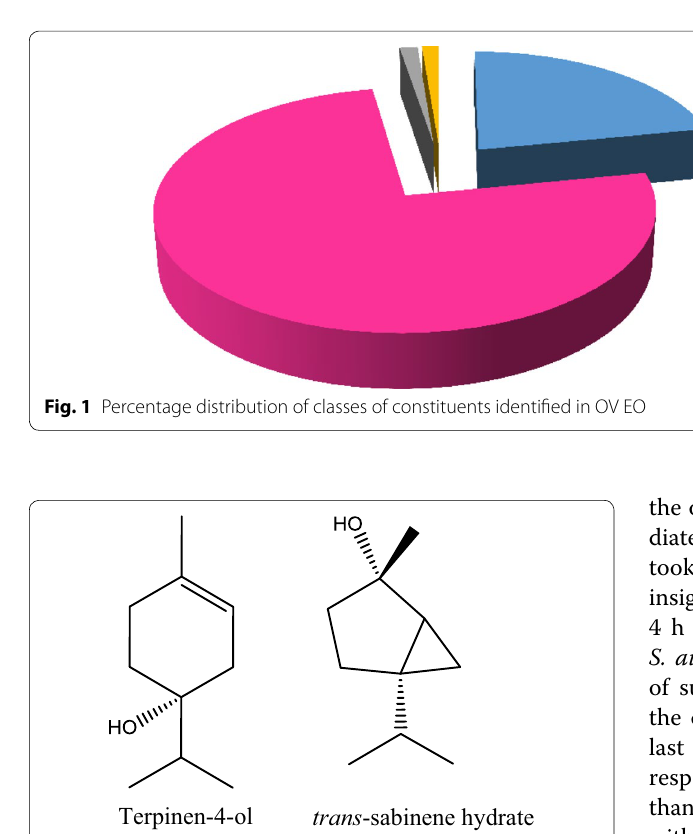
Table 2 Effect of Tween 20 and Cremophor El on the antimicrobial activity of OV EO